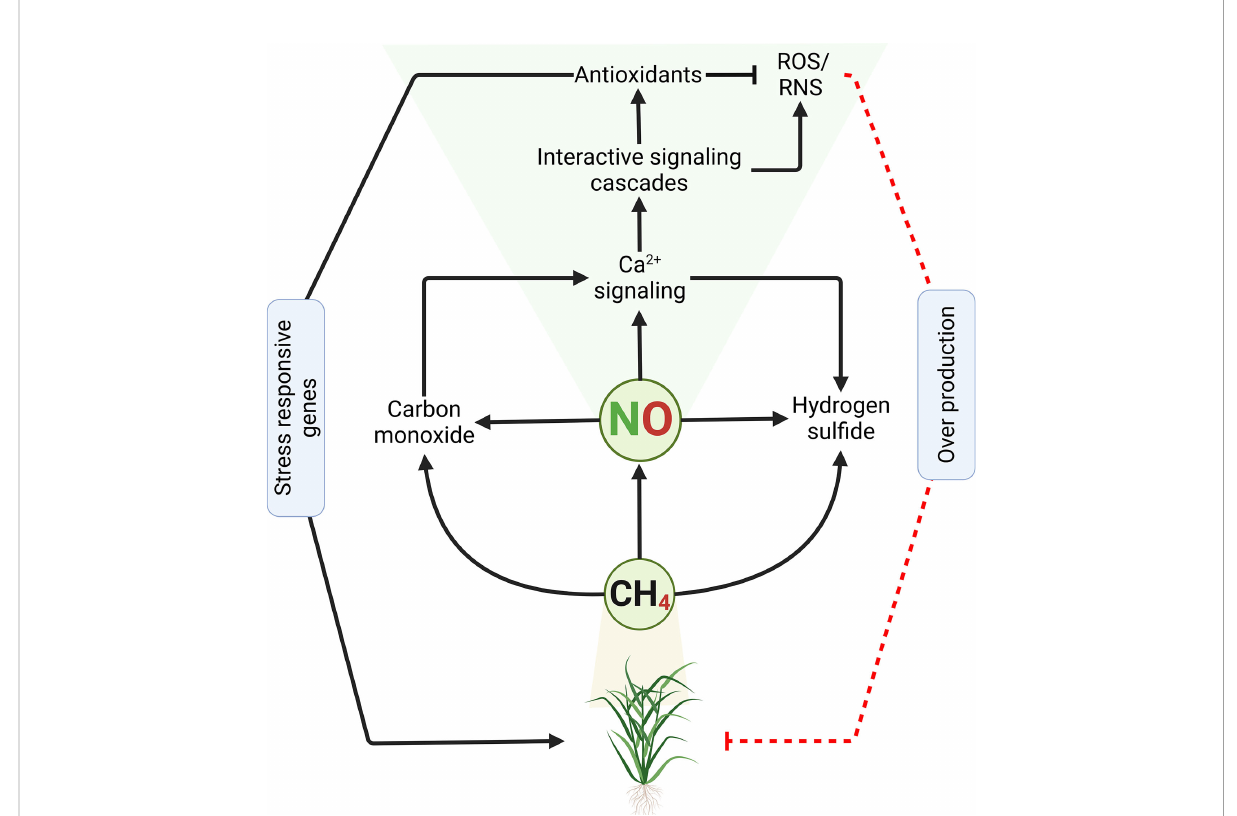
FIGURE 2 Methane induces nitric oxide accumulation in plants. High concentration of methane in the atmosphere or within the plant triggers activation of various signaling and biosynthetic pathways, including NO. NO requires Ca 2+ , among others, as cofactors to govern the adaptive response mechanisms towards abiotic stress in plants. The crosstalk between NO and Ca 2+ along with other signaling cascades helps the plant to activate the appropriate defense system to tackle the stress, by inducing related stress-responsive genes and accumulation of various antioxidant systems that detoxify the effect of reactive oxygen (ROS) and nitrogen (RNS) species over accumulation. Persistent over production of ROS and/ or RNS leads to oxidative stress/damage that may culminate to cell death and plant necrosis. Continuous black lines with an arrow indicate positive regulation or induction, while dash red line with a perpendicular bar denote negative regulation or